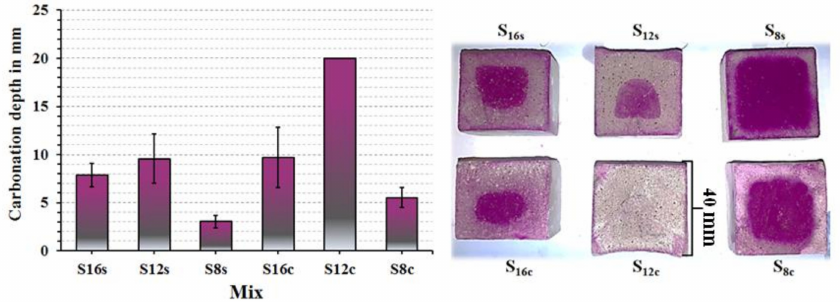
Figure 9. Carbonation depth of the AASs mortars specimens (40 × 40 mm 2 ) determined after 3 months of storing at 20 ± 2 ◦ C and 50 ± 10%